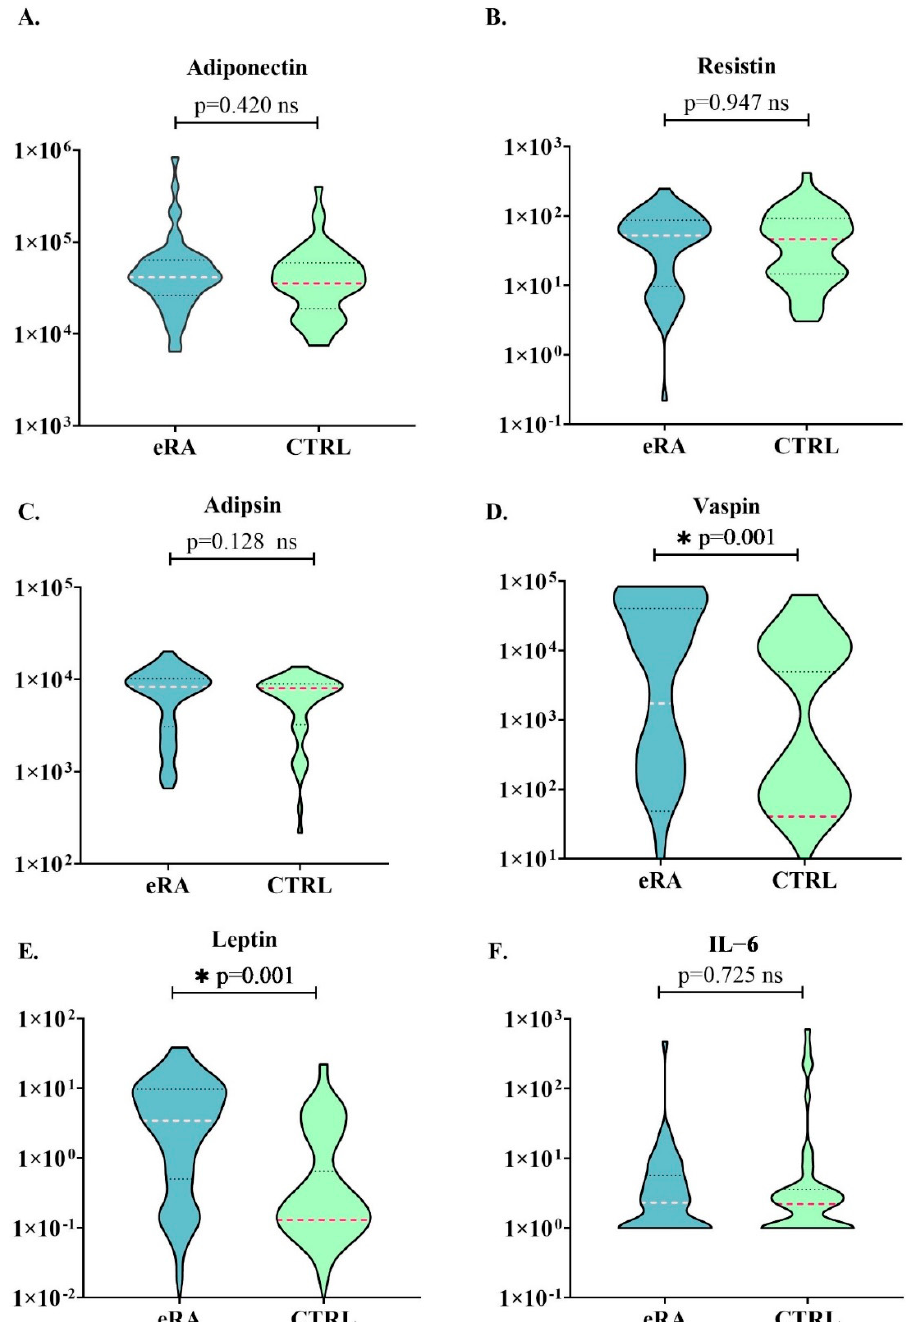
Figure 1. Comparison of adipokine levels in eRA patients and controls. eRA: early–RA group. CTRL: control group. Red/pink line: median of each group; gray lines: quartile 25th and 75th of the graph. * p >